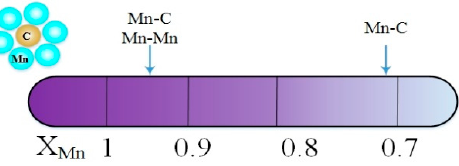
Figure 4. Environment of each atom in Mn–C binary alloys determined from MIVM modeling.